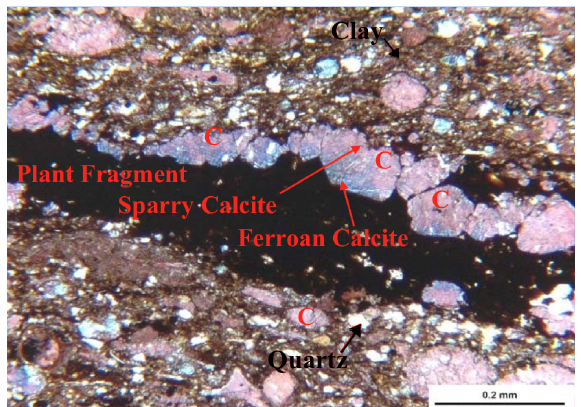
Figure 6. Thin section photomicrographs corresponding to the calcite rich location (marked T in Figure 4) showing extensive calcite cementation (marked C) as well as Quartz particles and clay. The dark matter in the image is a plant fragment containing sparry and ferroan calcite. Variation in ferroan calcite indicates multiple stages of cementation and